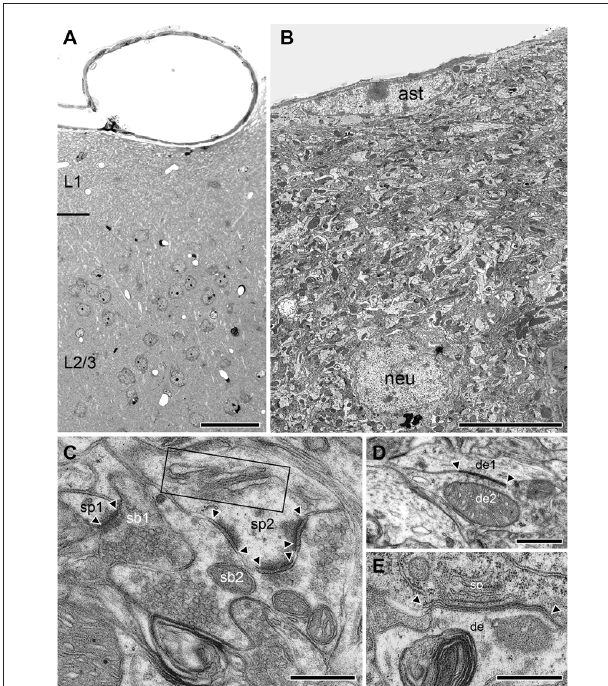
FIGURE 6 | Structural organization of L1 in the adult WT neocortex. (A) Semithin section trough the superficial part of the WT neocortex from the pial surface to the superficial part of L2/3. Note the absence of neurons in L1 in this image but their abrupt occurrence in the underlying L2/3. Scale bar 10 µ m. (B) Low power EM micrograph from the pial surface to deep L1 showing the organization of the neuropil including small caliber axons, dendrites and synapses of different shape and size. Infrequently GABAergic interneurons (neu) were found identifiable by their typical nuclear enfolding. Note also the astrocytes (ast) with its fine processes located directly underneath the pial surface. Scale bar 10 µ m. (C) High power EM micrograph of two adjacent synaptic boutons (sb1, sb2) terminating on two different spines (sp1, sp2) in L1. The smaller (sp1) had only a single active zone whereas the larger spine (sp2) contained a spine apparatus (framed area) and three active zones (arrowheads). Scale bar 0.25 µ m. (D) Tight-junction (arrowheads) between two adjacent dendrites (de1, de2). Scale bar 0.5 µ m. (E) Gap-junction (arrowheads) between the soma (so) and a dendrite (de). Scale bar 0.5 µ m.